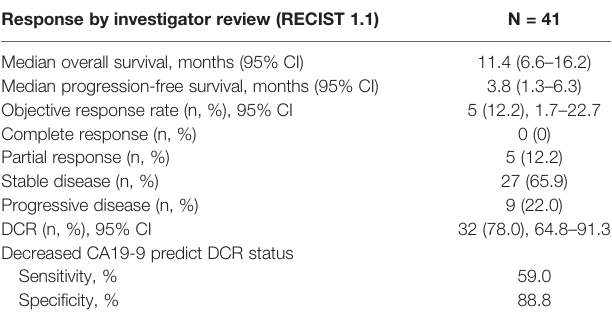
TABLE 2 | Tumor responses based on RECIST 1.1 and predictive ability of biomarkers. Response by investigator review (RECIST 1.1)